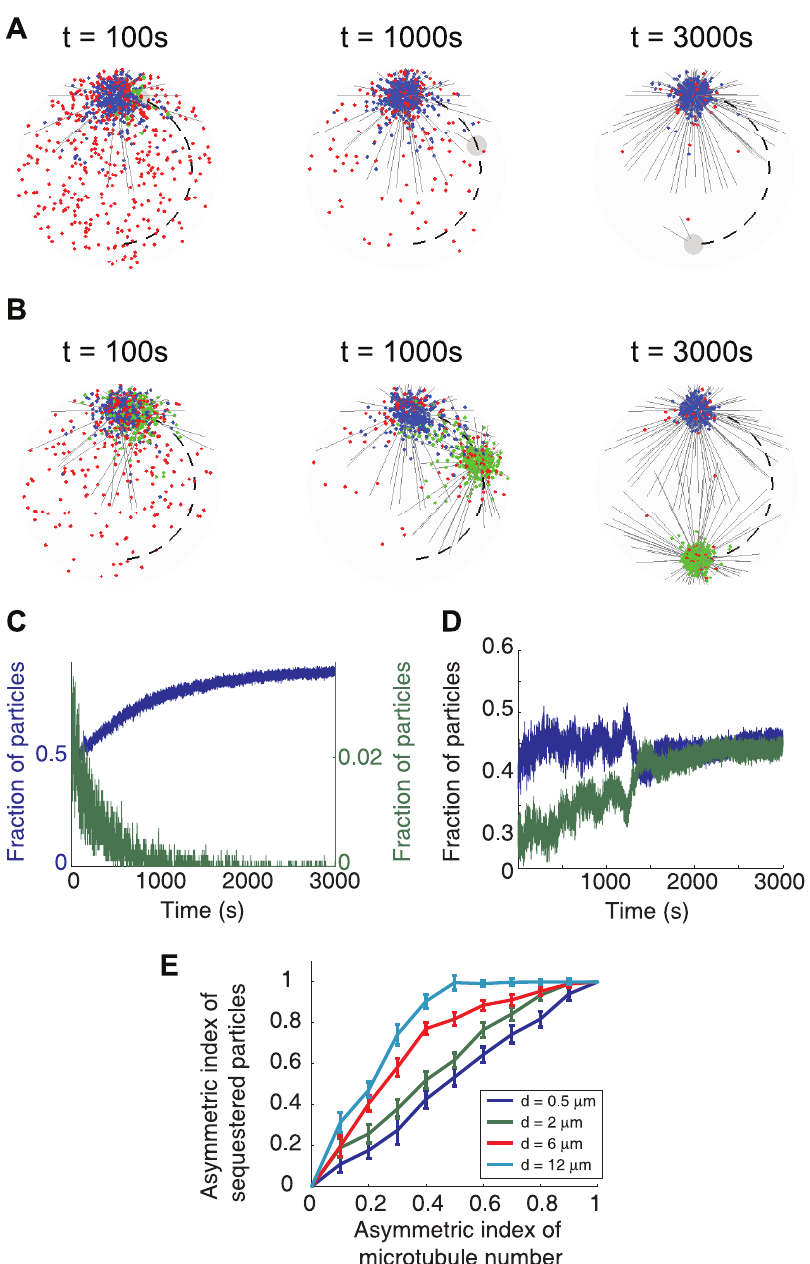
Figure 3. Delayed centrosome maturation causes asymmetric particle partitioning. (A) Time series of dynein distribution with , 1 hr time delay between the centrosome maturation (also see Movie S3). During the simulated duration of 3000 s, the number of microtubules organized by the dominant centrosome increases from 200 to 800. The second centrosome organizes 20 microtubules throughout the time. It migrates along the trajectory depicted by the dashed curve. Dyneins are sequestered by the dominant centrosome. Dark grey lines: microtubules (only 1 out of 10 are shown to reduce clutter); blue dots: dyneins bound to the microtubules organized by the dominant centrosome; green dots: dyneins bound to the microtubules organized by the second centrosome; red dots: dyneins freely diffusing in the cytoplasm; grey circles: centrosomal area. (B) Time series of dynein distribution with , 5 min time delay between the centrosome maturation (also see Movie S4). During the simulated duration of 3000 s, the number of microtubules organized by the first centrosome increases from 200 to 800; the number of microtubules organized by the second centrosome increases with the same rate from 150 to 750. The second centrosome migrates along the same path as in (A) (dashed curve). Dyneins ends up equally distributed around the two centrosomes. Legends are same as in (A). (C) and (D) Time trajectories of the number of dyneins bound to the microtubules associated with each centrosome. (C) corresponds to the case in (A), and (D) corresponds to (B). Blue line: the centrosome that matures earlier; green line: the centrosome that matures later (right axis in (C)). With long time delay in centrosome maturation, the number of dyneins sequestered by the second centrosome decreases to nearly zero before the centrosome matures. With short time delay, the original bias in the partitioning of dyneins diminishes as the relative difference in the numbers of microtubule organized by the two centrosomes reduces. (E) Asymmetry of particle partitioning depends on the asymmetry of microtubule numbers organized by the two centrosomes, as well as the distance between the centrosomes. The asymmetric index is defined as (N 1 2 N 2 )/(N 1 + N 2 ), where N 1 and N 2 are the corresponding steady state particle numbers or microtubule numbers associated with each centrosome. The simulations were run with a total number of 1000 microtubules partitioned differentially between the two centrosomes.